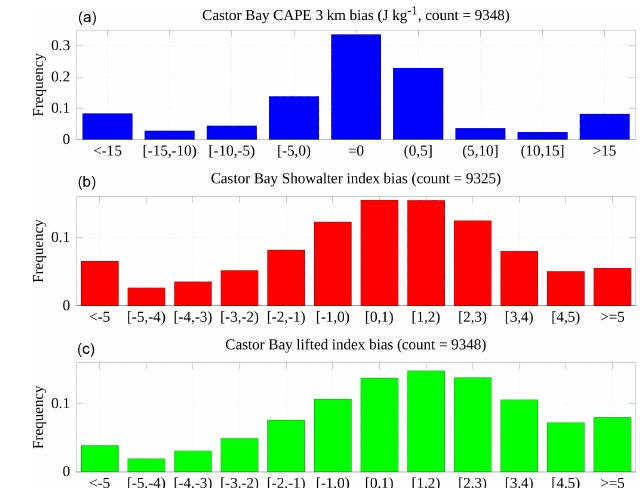
Figure 13. Error distributions for three COSMO-CLM parame- ters, found through comparison with Castor Bay radiosonde data. (a) Cape 3km. (b) Showalter index. (c) Surface lifted index.